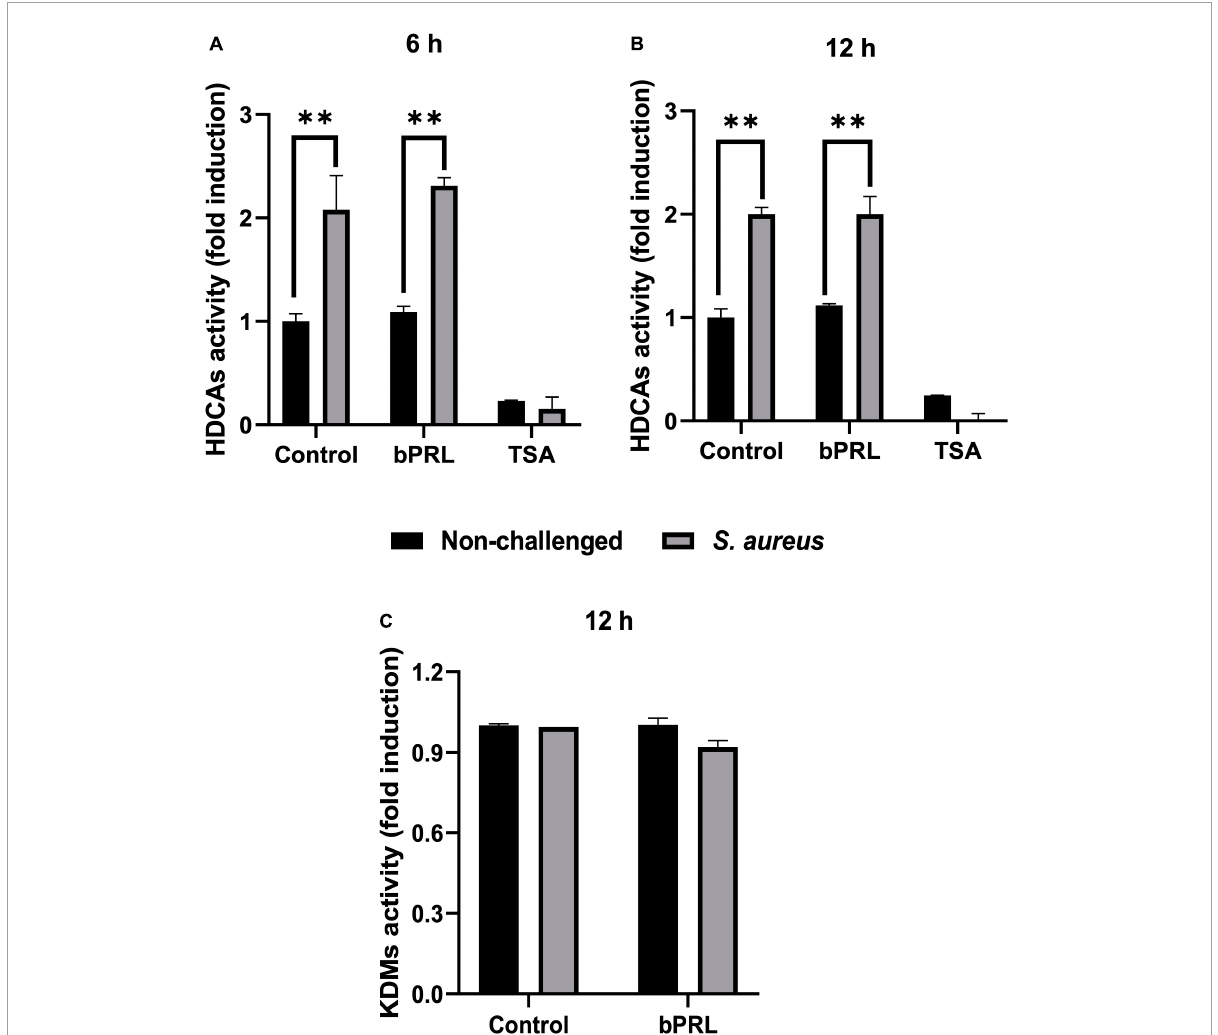
FIGURE2 Activity of HDACs and HDMs in bMECs treated with bPRL and challenged with S. aureus . bMECs were treated (A) 6 and (B) 12 h with bPRL (5 ng/ml) and then were challenged or not 2 h with S. aureus (MOI 30:1). HDACs substrate was added and incubated according to